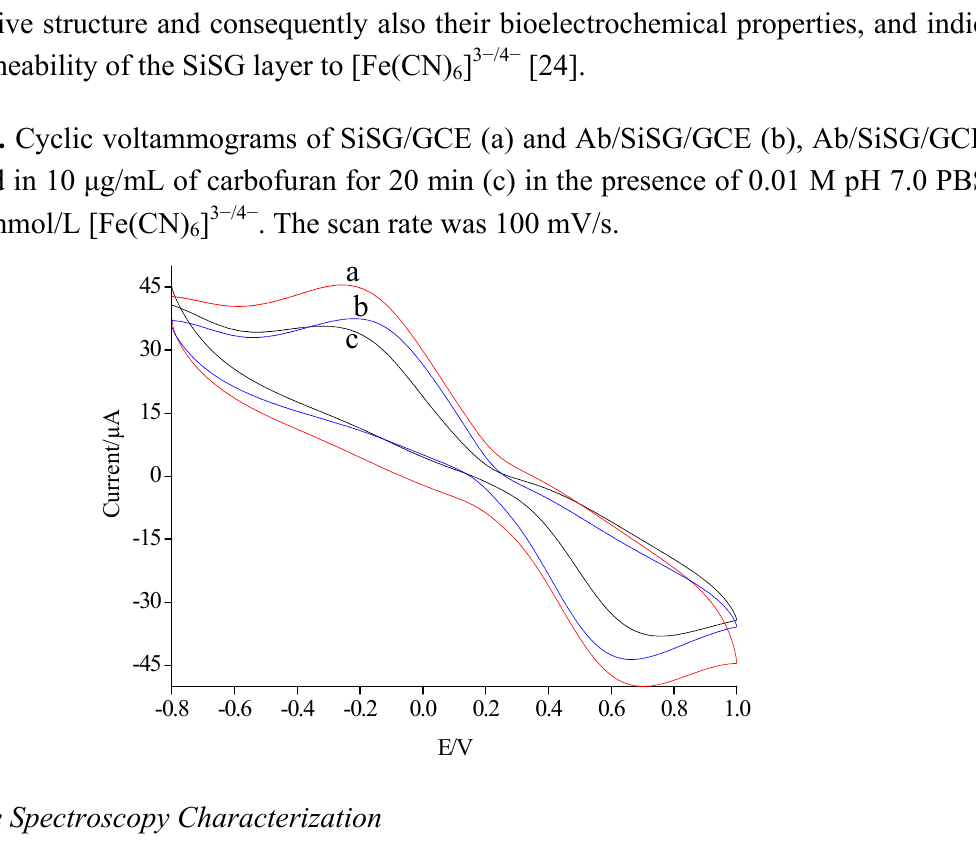
Figure 2. Impendance spectra corresponding to SiSG/GCE in 5 mmol/L [Fe(CN) solution: (a), the Ab/SiSG/GCE before (b) and after (c) incubation in 10 μ g/mL of carbofuran in the presence of 0.01 M PBS (pH 7.0) solution and 5 mmol/L [Fe(CN)